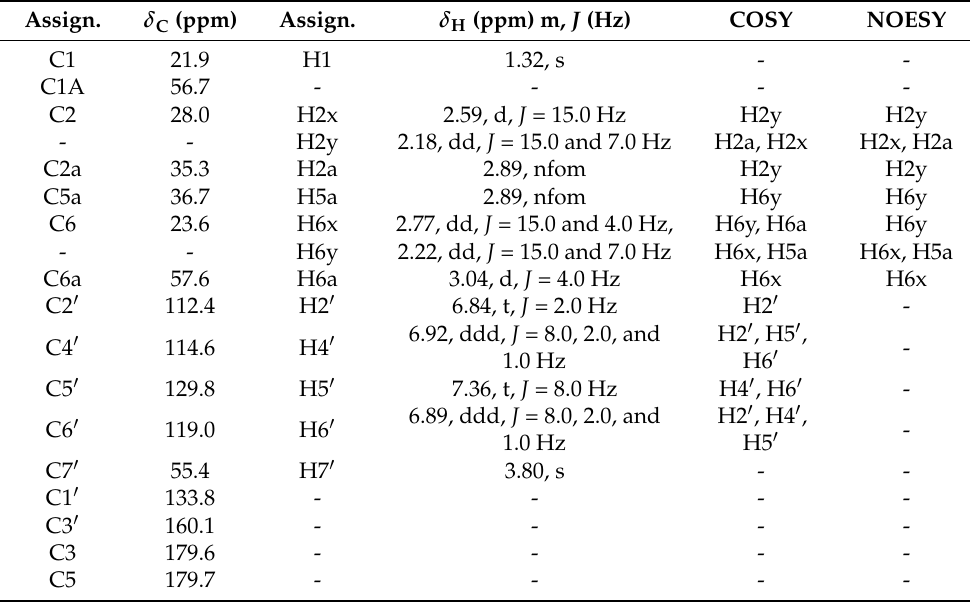
Table 1. Experimental 1 H and 13 C NMR chemical shifts, COSY, and NOESY correlations for com- pound 5b *. Assign. δ C (ppm)